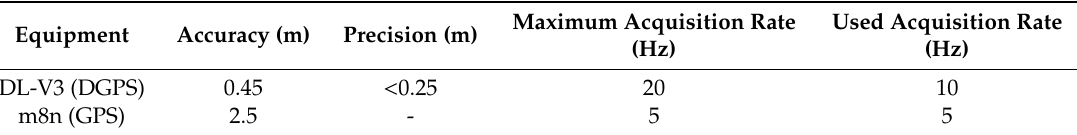
Table 2. Characteristic of the GPS and DGPS systems